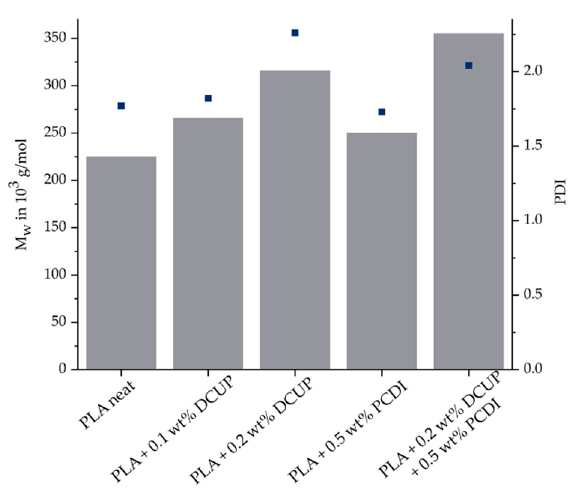
Figure 2. SEC-Results of all PLA compounds.